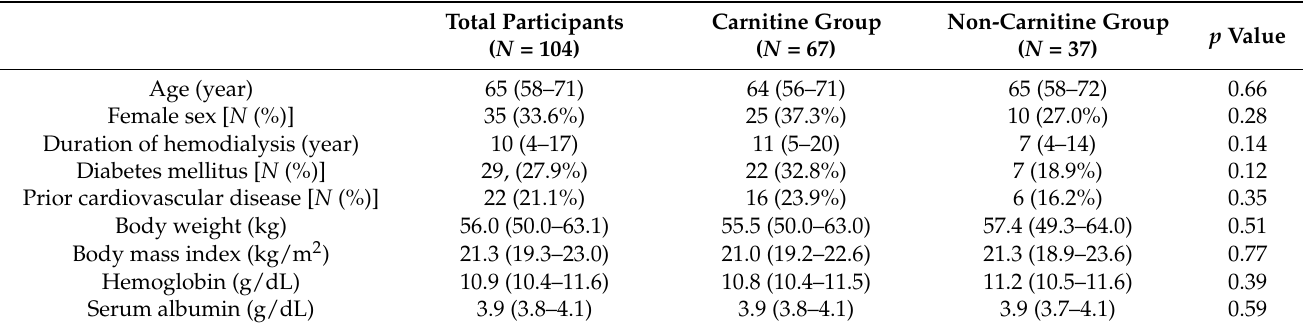
Table 1. Characteristics of